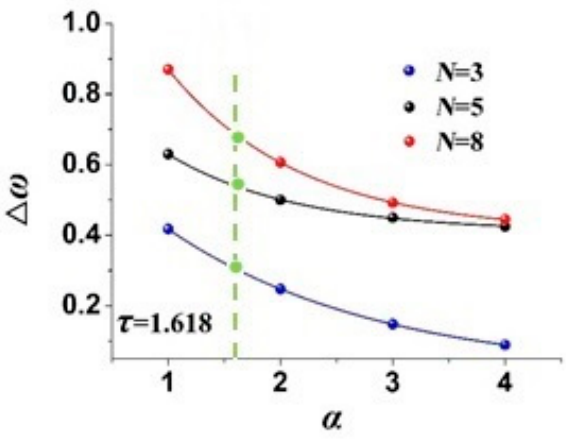
ωΔ α and for 3,5,8 N = . The dotted line indicates the posi-